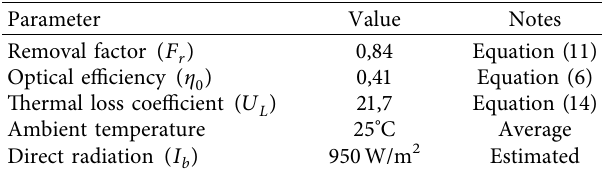
Table 3: Experimental values for collector